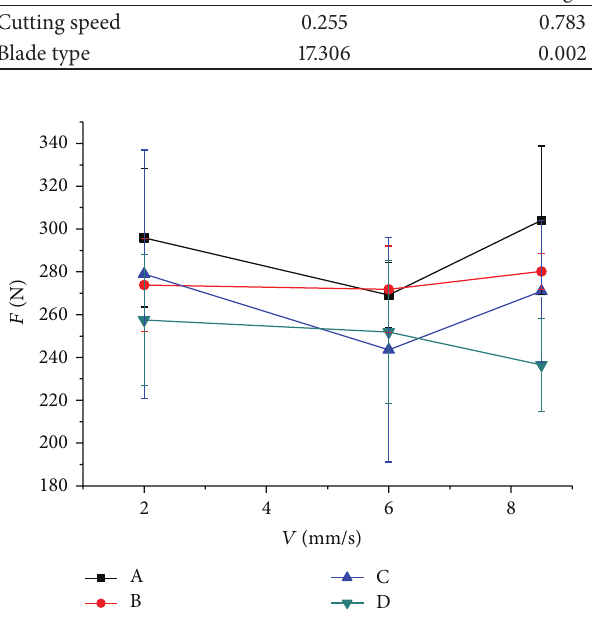
Figure 8: Soil-cutting work of 4